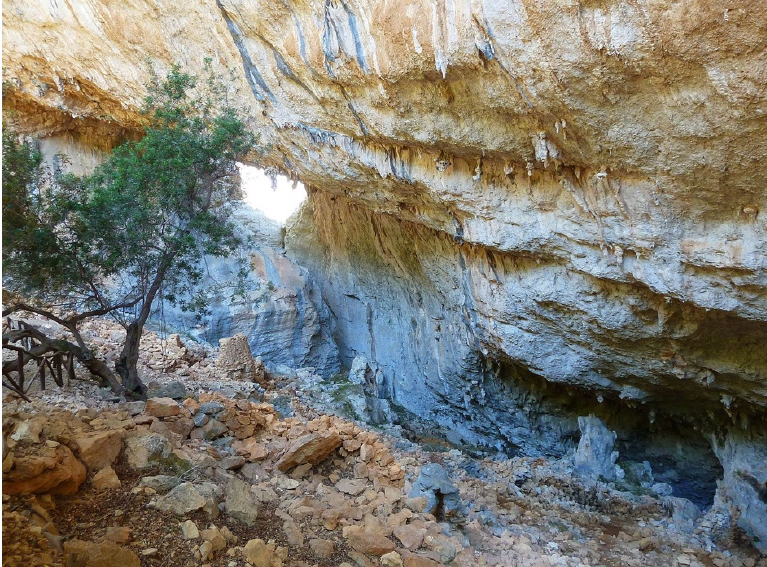
Figure 10. Tiscali, Nuragic archaeological site in Sardinia (‘Tiscali, nuragic archaeological site in Sardinia.’ by Roberto Mura 2017/Wikimedia Commons is released under CC BY-SA 4.0). The *th-/*#[ θ ]- root consonant of the village has proven to be an enigma to scholars, attracting various convincing and probable views. Thìscali is not the only region with this prefix. Other Sardinian place names, such as Thìscali, Nuraghe Thorcodossile (in Oliena), Thorra (at Lodè), also contain this unique phonemic feature.